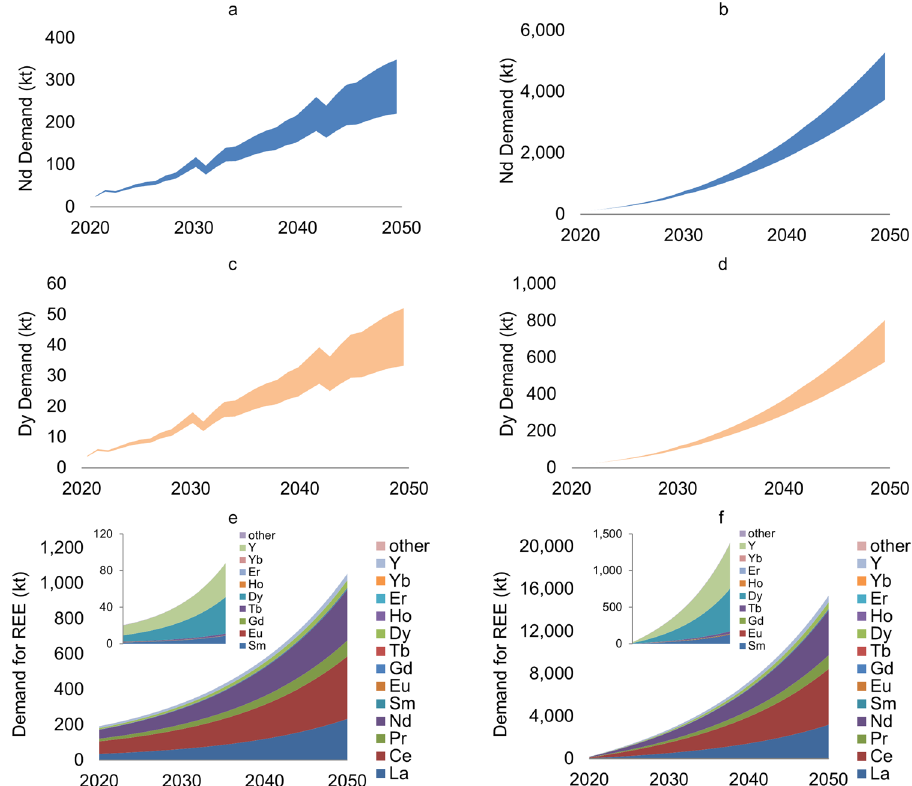
Fig. 1 REEs demand. a Nd annual demand; b Nd cumulative demand; c Dy annual demand; d Dy cumulative demand in WP and EVs in the two demand scenarios; e individual REEs annual demand in all applications; and f individual REEs cumulative demand in all